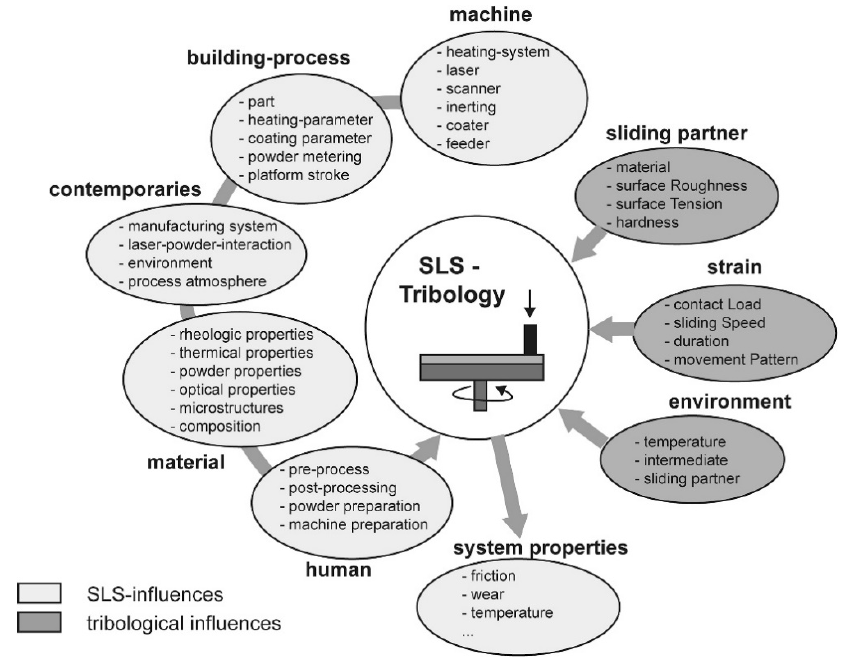
Figure 2. Factors affecting tribological properties of selective laser sintering (SLS) parts. Reproduced from [29], with permission from Elsevier, 2018.